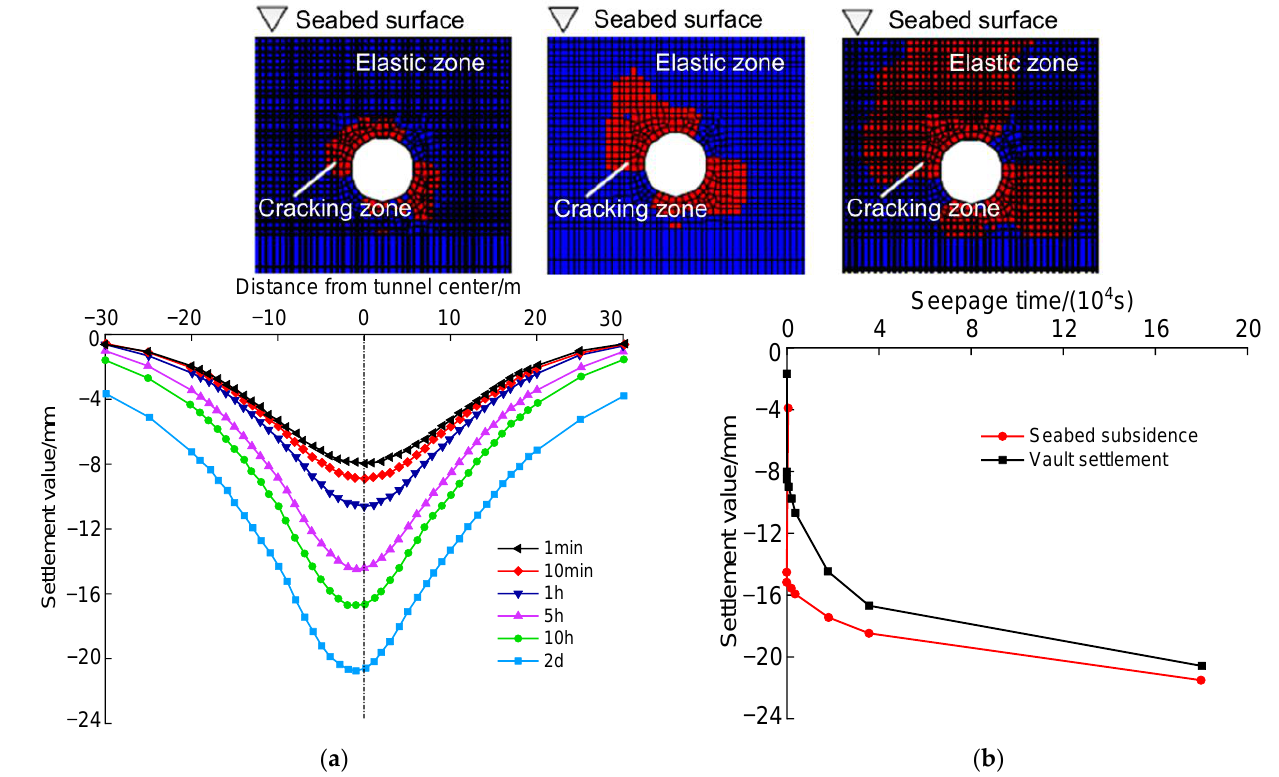
Figure 12. Evolution process and characteristics of hydraulic fracturing formations [67]. ( a ) Changes in seabed settlement; ( b ) corresponding relationship between seabed and dome settlement.